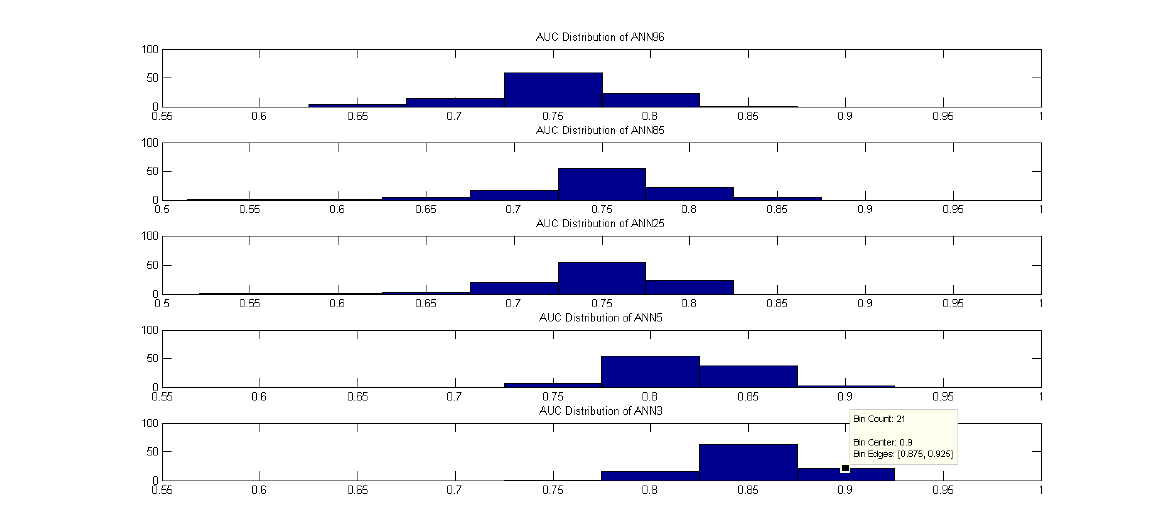
Figure 9. AUC distribution for each ANN to diagnose using the HMS